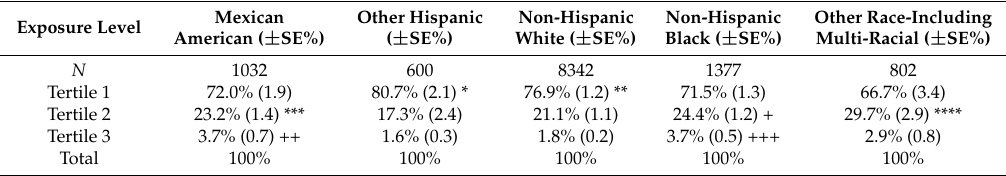
Table 4. Ethnicity and Tertiles of Exposure.